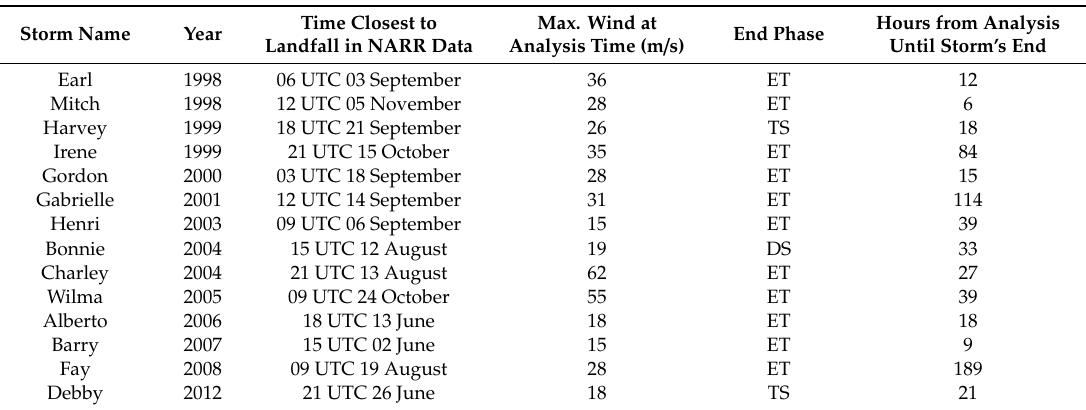
Table 3. As in Table 1 but for eastern group